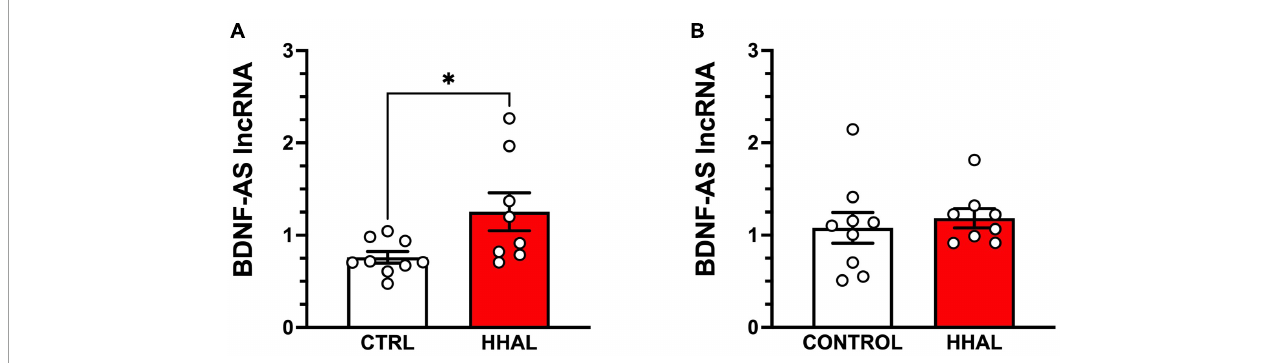
FIGURE4 BDNF-AS levels are increased in the DLPFC but not the EC following chronic administration in the HHAL group. In the DLPFC (A) , BDNF-AS lncRNA levels were significantly greater in the HHAL group compared to the CTRL group ( t = 2.414, df = 15, P = 0.029); however, in the EC (B) no significant differences were observed between the HHAL and CTRL groups ( t = 0.5113, df = 15, P = 0.6166). For each subject, BDNF-AS levels were calculated as quantitative mean value divided by the average of the quantitative mean values for the two reference genes for the respective regions. Bars represent the mean ± S.E.M. for the respective groups. Circles denote expression levels for individual subjects per group. * p <